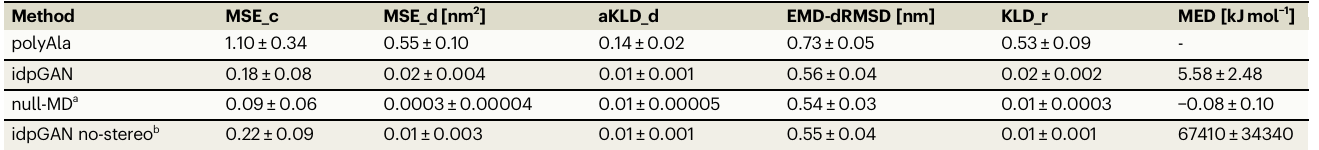
Averagevaluesarereported along with standard errors forall theproteins in the set ( n =31). Source dataareprovided as a Source Data fi le. a independent MD run compared with the reference MD